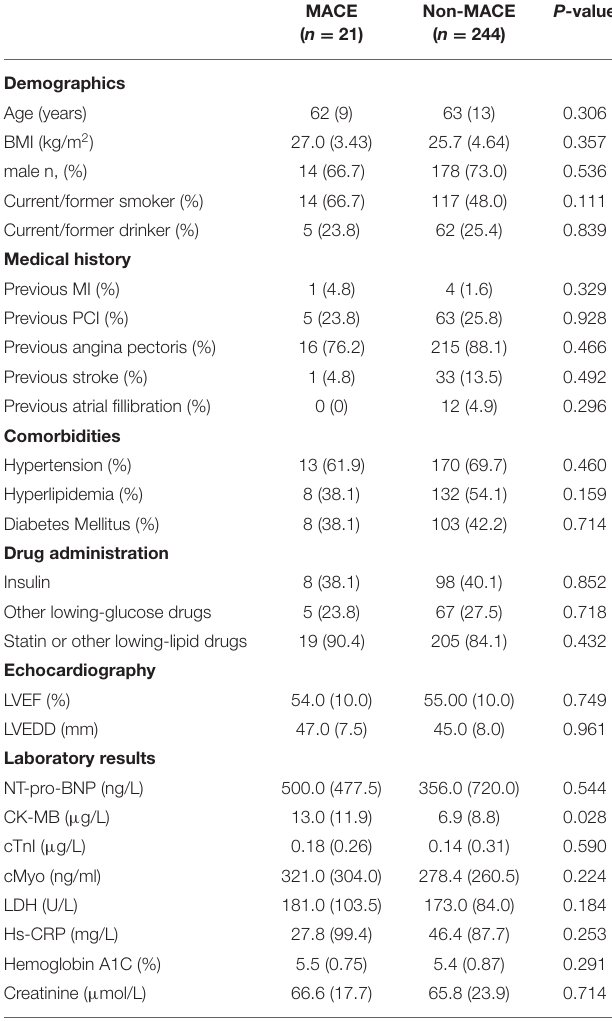
TABLE 1 | Clinical characteristics of 265 patients with MI after CABG